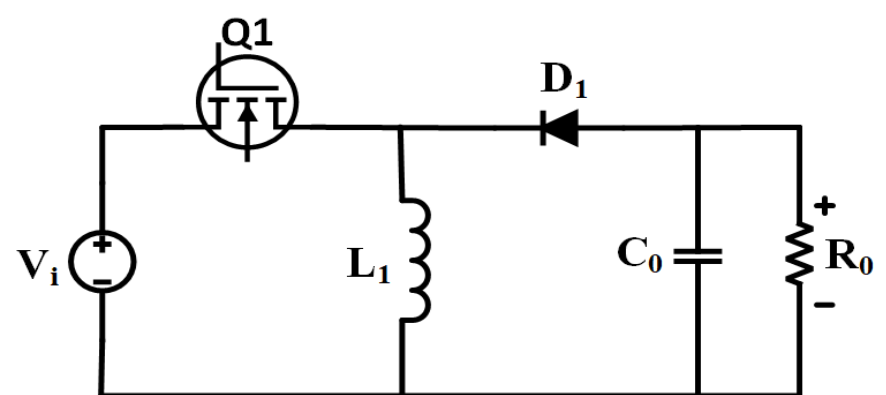
Figure 7. DC-DC buck–boost converter.